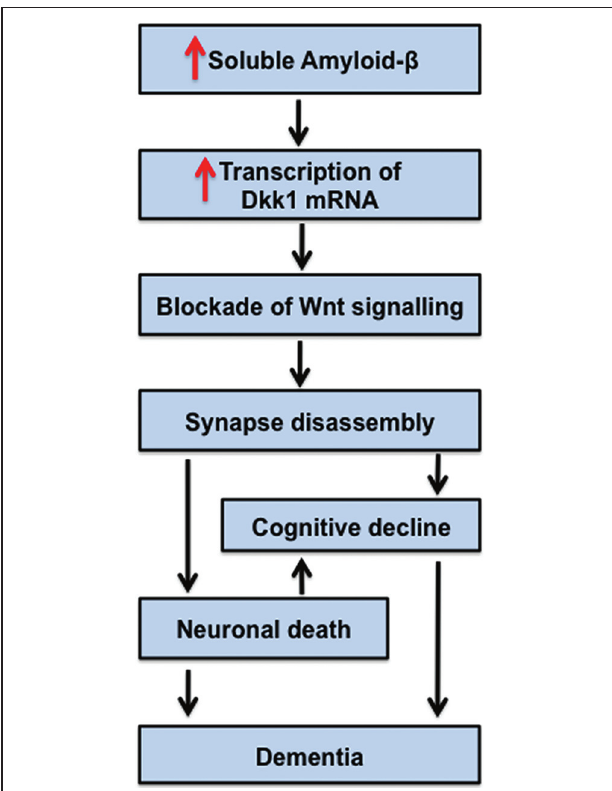
FIGURE 5 | Model for Dkk1 in the progression of AD . Increased levels of soluble Amyloid- β stimulate the transcription of Dkk1, which blocks endogenous Wnts important to the stability of synapses. Thus, Dkk1 induces synapse disassembly by the dispersal of synaptic components. Loss of synapses correlates with cognitive decline. We propose that Dkk1-induced synapse elimination is an early event in the progression of AD. The notion that synapse disassembly precedes cell death is in accordance with current models for the progression of